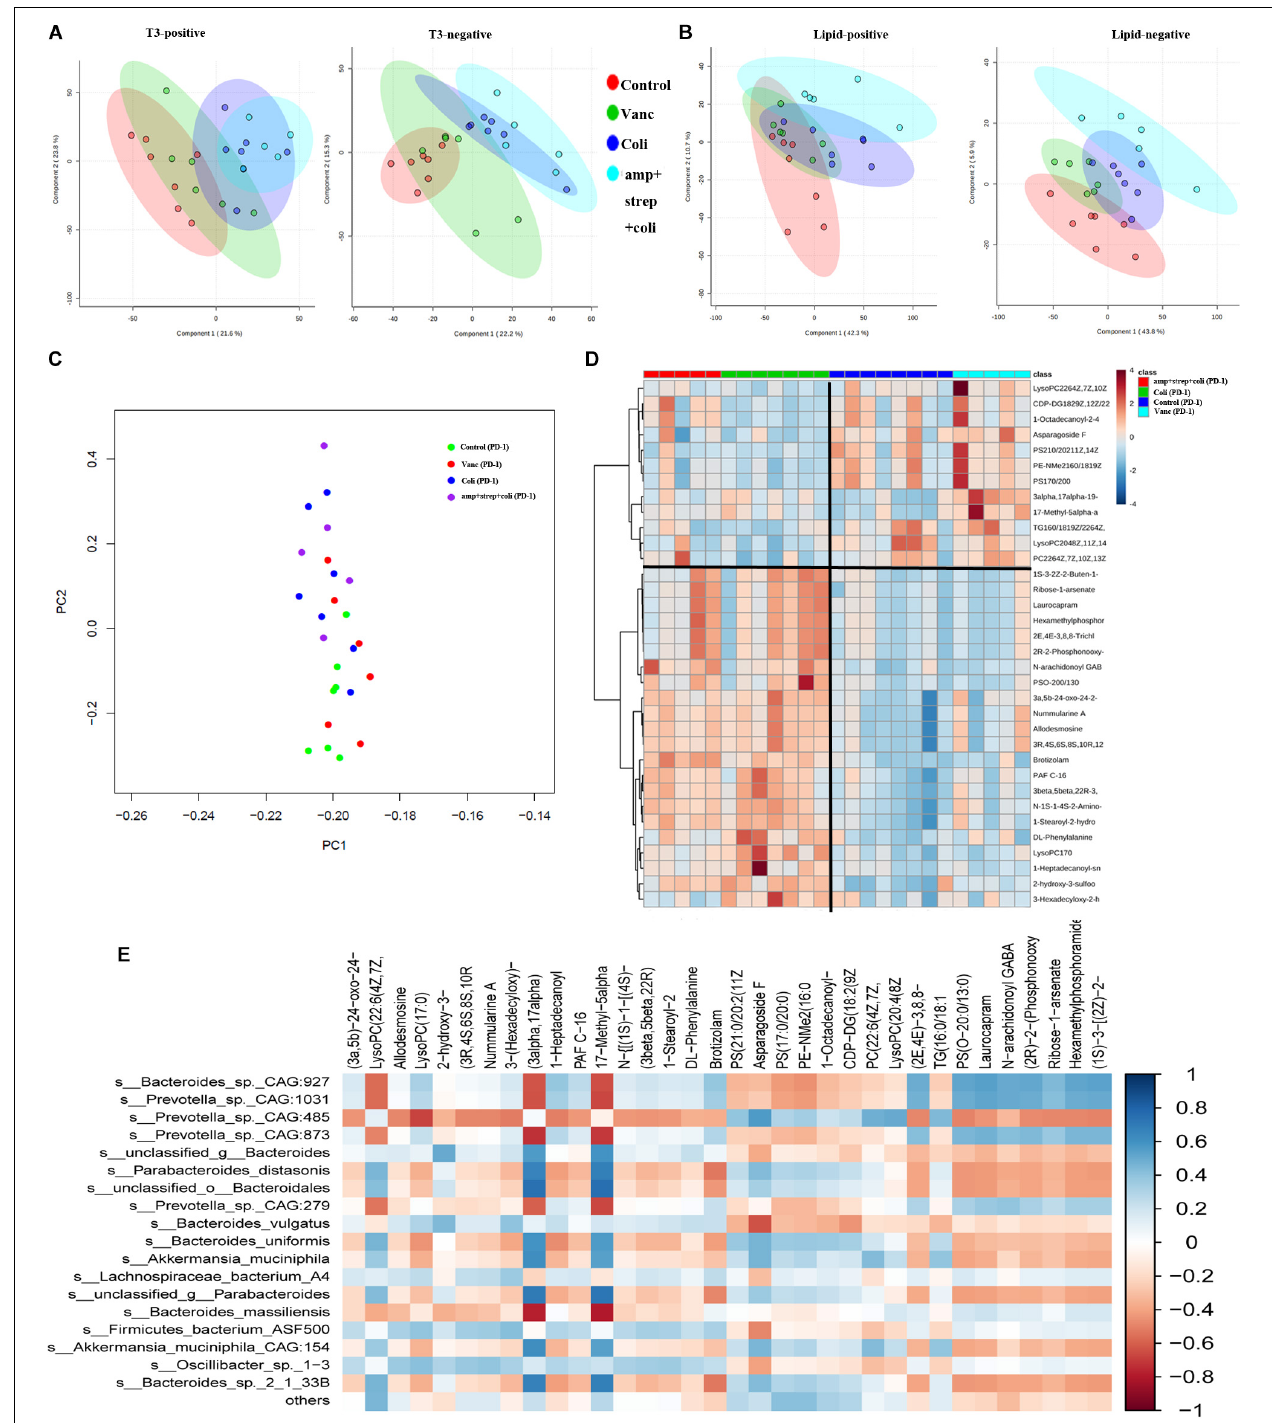
FIGURE 5 | Gut microbiota induces specific changes in plasma lipids and metabolome. (A) PCA graphs of the plasma metabolome from QC samples in positive and negative metabolomics analysis. (B) PCA graphs of the plasma lipidome from all samples. (C) PCA of plasma metabolites from after PD-1 antibody treatment group mice. (D) Heatmap shows the normalized relative abundances of metabolites with annotation which were significantly changed in Control vs. Coli group and Vanc vs. Coli group. (E) Correlations between the gut microbiota (at the species level) and potential plasma compounds. Cells are colored based on Pearson correlation coefficient between predominant bacteria (relative abundance) and metabolites (normalized abundance) in plasma. The red color represents a significant negative correlation ( P < 0.05), the blue color represents a significant positive correlation ( P < 0.05).